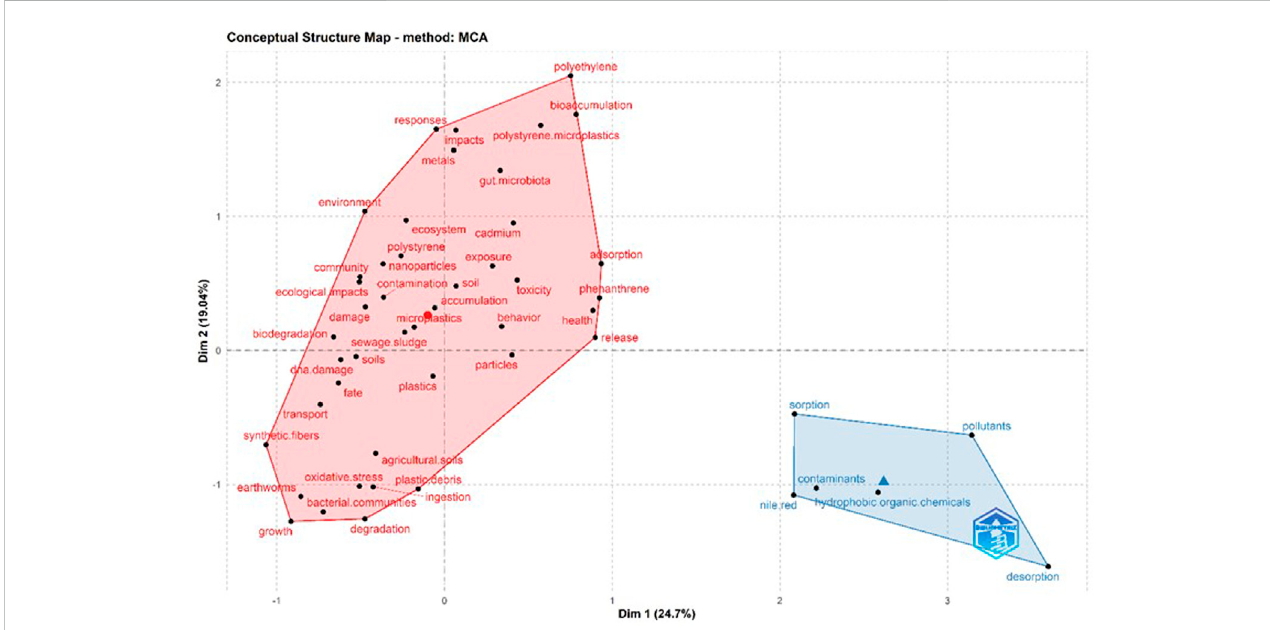
FIGURE 3 Keyword concept structure map. Two main clusters were identi fi ed: Cluster 1, blue and Cluster 2, red.